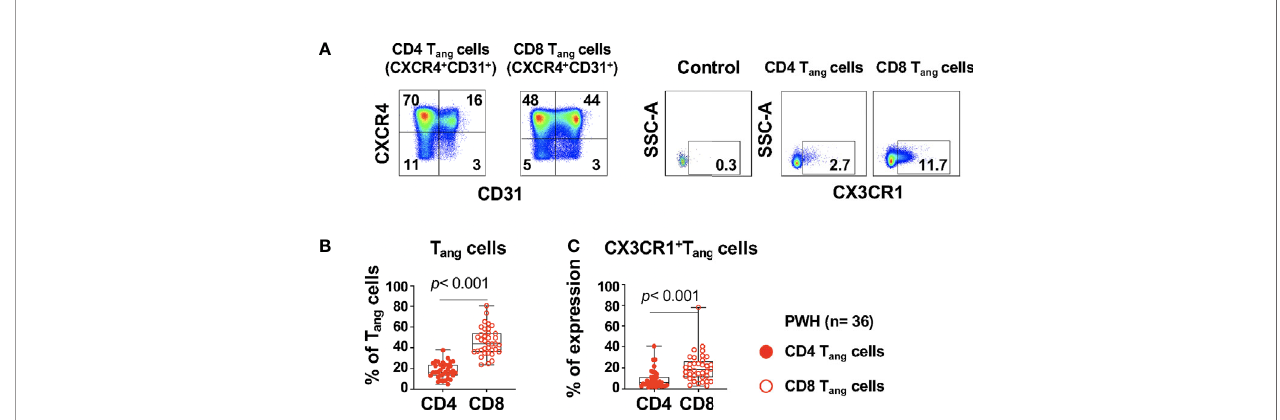
FIGURE 3 | Expression of CX3CR1 + CD4 and CD8 T ang cells in PWH. PBMCs from PWH (n= 36) were thawed and rested overnight. PBMCS were stained with LIVE/DEAD followed by a cocktail of mAbs described in Table Flow Cytometry Panel ( Supplementary Table S2 ). CD4 T cells were gated as CD3 + CD8 - and CD8 T cells were gated as CD3 + CD8 + . (A) CD4 and CD8 angiogenic T cells (T ang ) were identi fi ed based on surface expression of CXCR4 + CD31 + . Surface expression of CX3CR1 were analyzed in CD4 and CD8 T ang cells and full minus one (FMO) was used control. (B) Percentage CD4 and CD8 T ang cells. (C) Expression of CX3CR1 in CD4 and CD8 T ang cells expressed as frequency of the parent population. Comparison between CD4 and CD8 T ang cells was performed using nonparametric Wilcoxon test. P value < 0.05 was considered signi fi